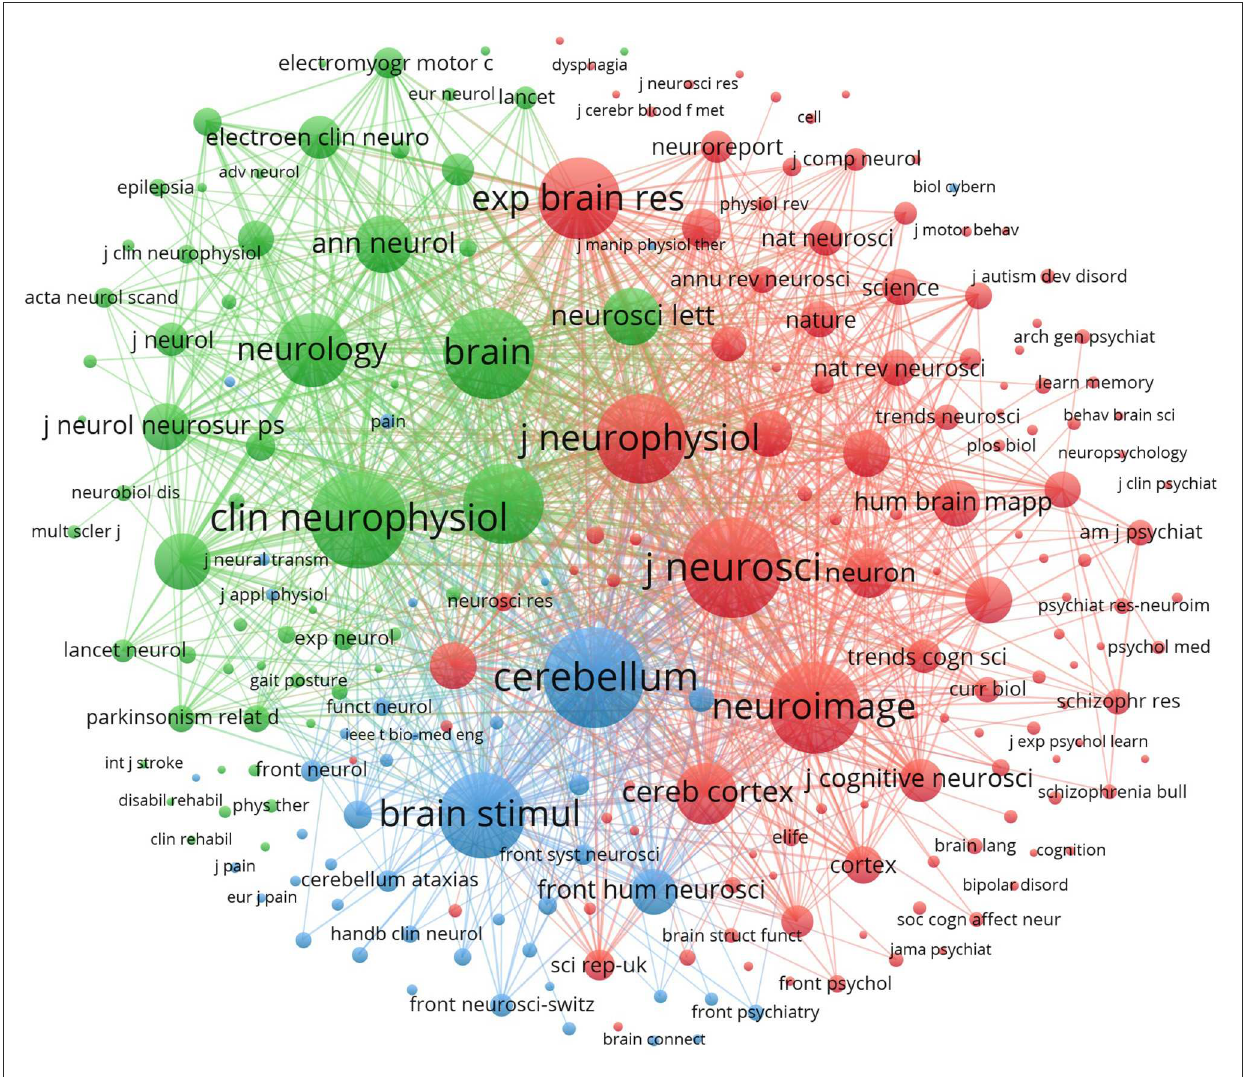
FIGURE7 Co-citation network map of journals in NICS field between 1995 and 2021.